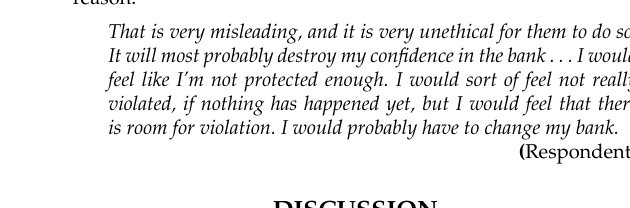
TABLE 2 Flesch Reading Ease score for South African banks’ Privacy Statements